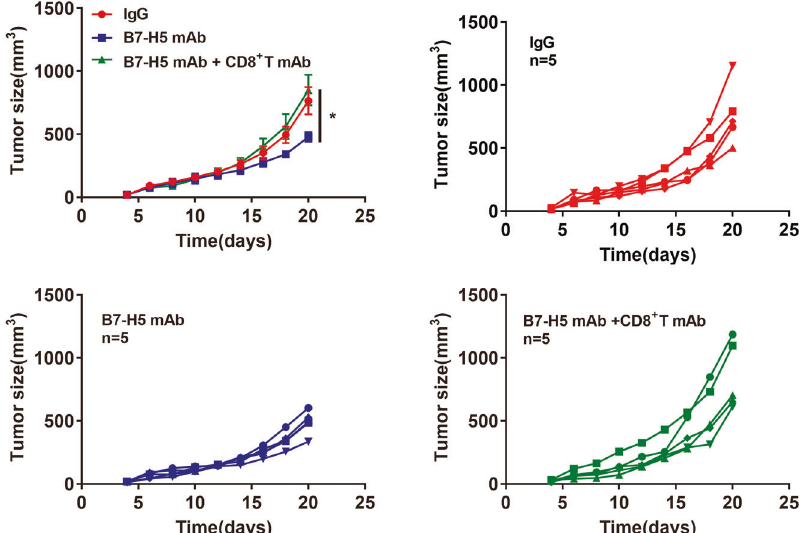
Fig. 4 B7-H5 blockade-mediated tumor growth inhibition was CD8 + T-cell dependent. Growth curve of MC38 tumors after co-treated with B7-H5 mAb and monoclonal anti-mouse CD8 (CD8 + T mAb). n = 5. The experiments were performed in triplicate. Values are expressed as means (SD). * P <